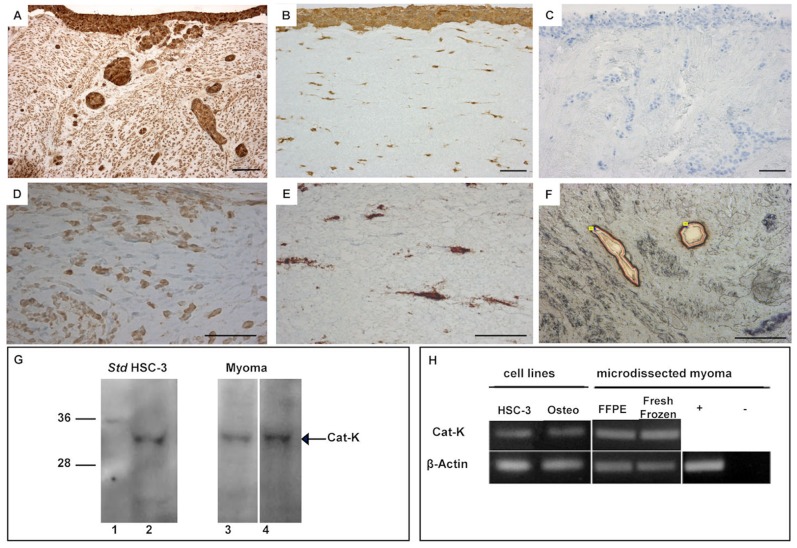
Cathepsin K expression in the myoma organotypic model.Invasive HSC-3 cells grown on myoma show intensive cathepsin K immunohistological staining (A). HSC-3 cells grown in type I collagen organotypic culture discs with embedded fibroblasts show cathepsin K staining in all cells present (B). Myoma tissue (without HSC-3 cells) as well as fibroblasts embedded in the collagen gel also stained with cathepsin K antibody (D–E). A negative control for immunostaining is shown (C). A Western blot confirmed that the monolayer cultures of HSC-3 cells (G, lane 2) and two distinct myoma tissue samples (without added carcinoma cells) contained cathepsin K (G, lanes 3 and 4). HSC-3 cells microdissected from the organotypic myoma model (F) of both formalin-fixed paraffin-embedded blocks (FFPE) and OCT-embedded frozen blocks (fresh frozen), as well as HSC-3 cells cultured in vitro in monolayers, express cathepsin K mRNA, as detected by RT-PCR (H). A differentiated human osteoclast progenitor cell line (Osteo) was used as a positive control for cathepsin K mRNA expression, represented by (+). Negative controls, where no sample was used, are demonstrated by (−) Scale bars 200 µm.